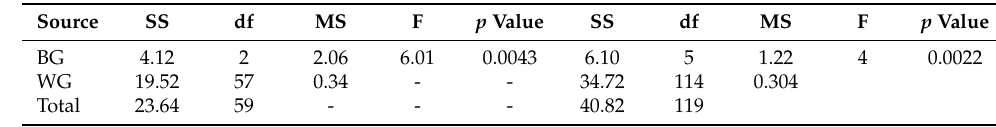
Table 9. Using the BIDMC dataset, the ANOVA results of the left side columns were obtained from the CASVR, CALSTM, and CAGBA; the right side columns were obtained from SVRMF, CASVR, LSTMMF, CALSTM, GBAMF, and CAGBA models.